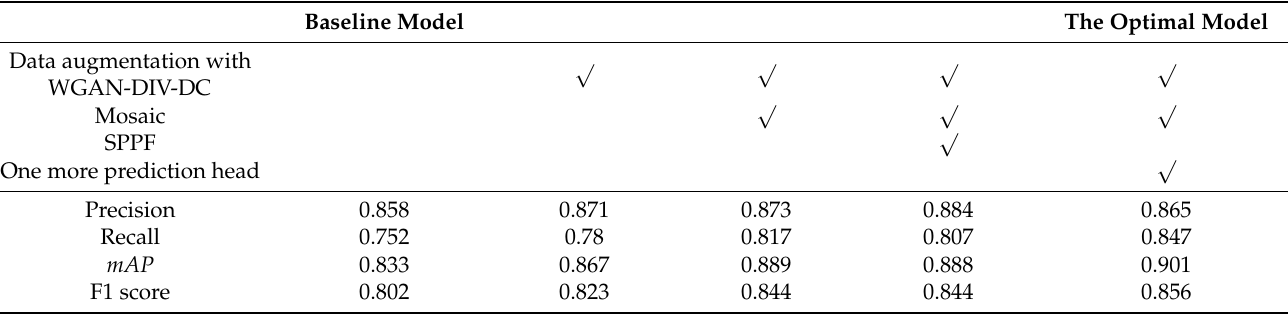
Table 4. The performance of the detection